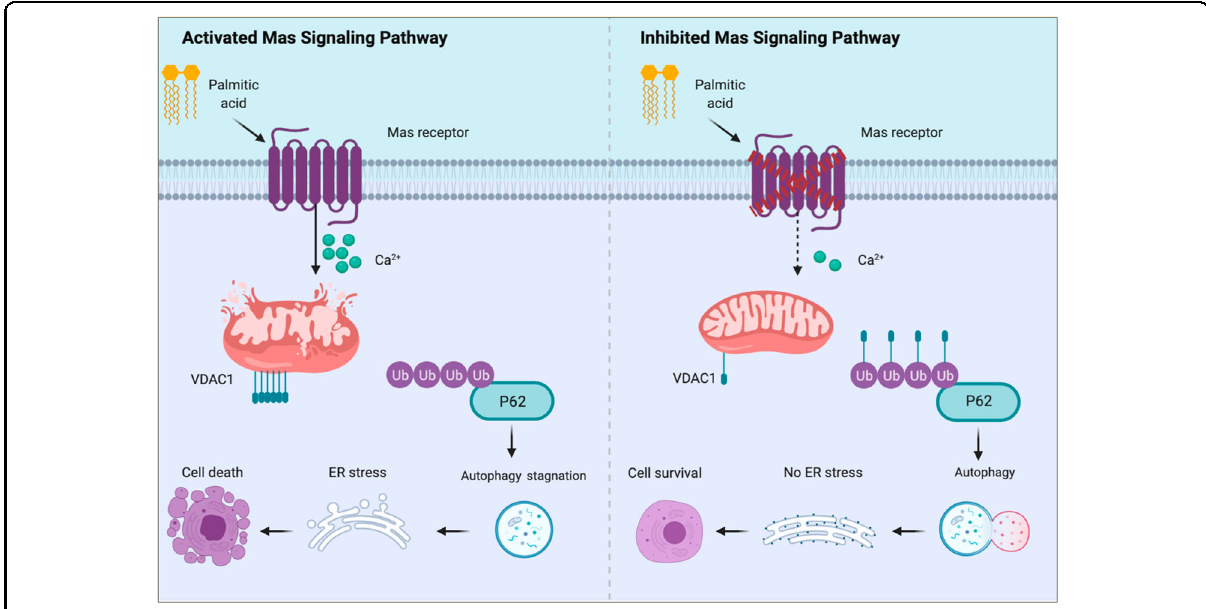
Fig. 9 A potential mechanism by which Mas mediates PA/high-fat-induced impaired autophagy fl ux and ER stress in proximal tubular cells. Activation of Mas resulted in increased intracellular calcium levels, via incompletely degradated VDAC1 due to failure in binding to P62 and ubiquitin, causing mitochondrial damage and accumulation of autophagosomes, which induces ER stress and